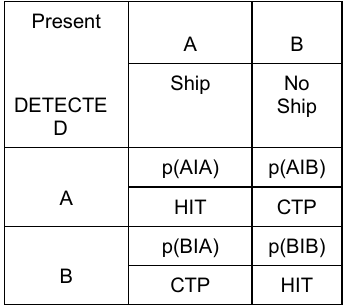
Table 3. Conditional probabilities, according to the CI ERP SDT model, generalized into two classes of equivalence geospatial objects ships and no ships